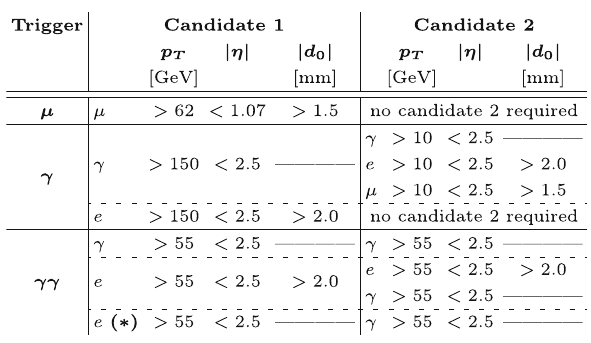
Table 4 Preselection criteria based on table 1 of Ref. [4]. According to the triggers which have been fired beforehand, the presence of one or two candidate objects with the specified properties is required for at least one of the triggers. As explained in the text, electron candidates tagged with a star (*) must be loosely